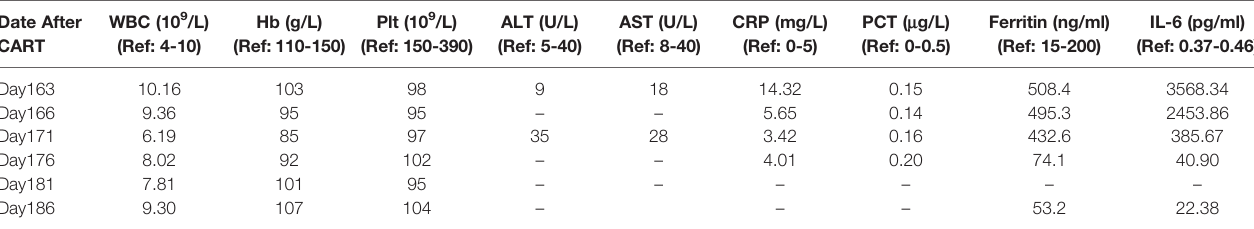
TABLE 2 | The laboratory results in Case